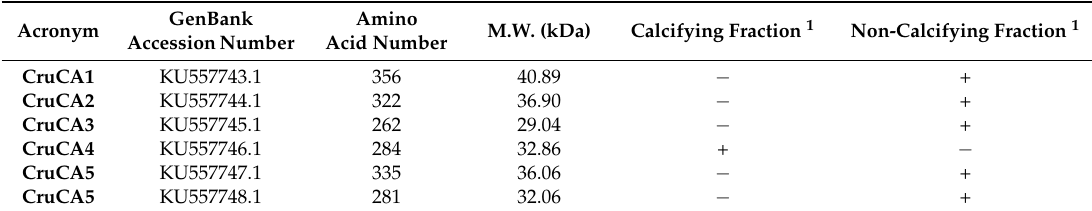
Table 1. Features and physiological localization of the α -CAs identified in the genome of the Mediterranean red coral, Corallium rubrum .